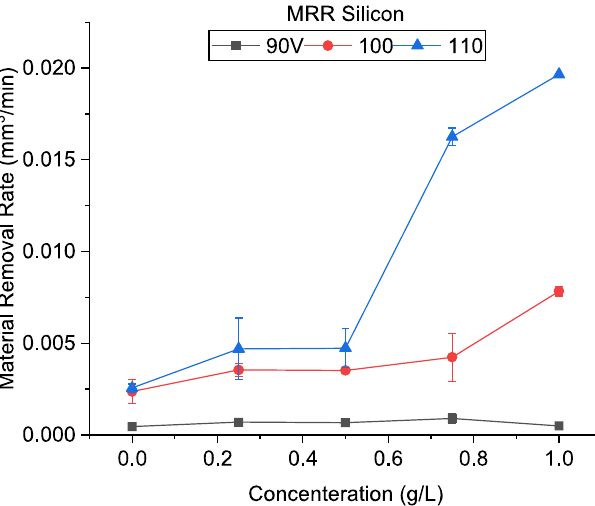
Figure 19. Material removal rate using silicon-mixed EDM.